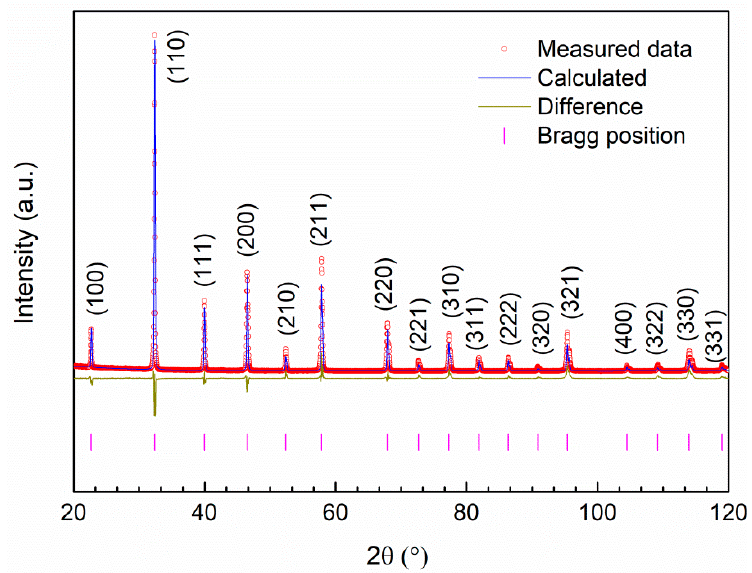
Figure 2. The Rietveld refinement profile of the Ba 0.5 La 0.5 Co 0.5 Fe 0.5 O 3 − δ powder (R w = 16.77%, Re = 12.14%). The data points are denoted by circles, the refined pattern is a solid line. Below the refined pattern, a difference plot is shown. Bragg positions of the cubic perovskite structure phase are presented by vertical bars at the bottom. Table 3. Structural parameters obtained from the Rietveld refinement of the Ba 0.5 La 0.5 Co 0.5 Fe 0.5 O 3- δ pattern along with iodometric titration results.